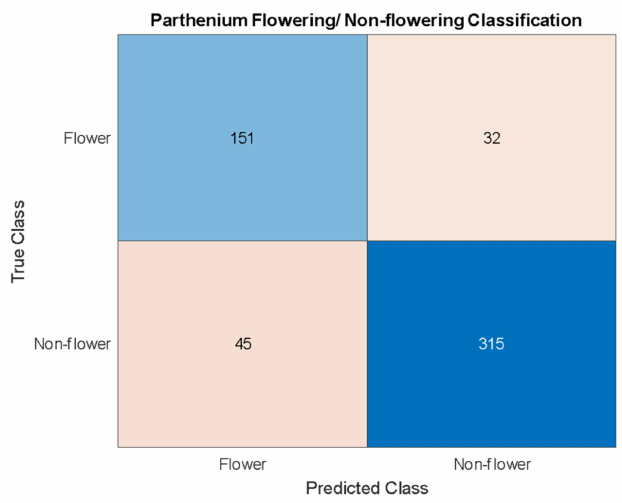
Figure 10. Confusion matrix depicting predicted parthenium weed/background class numbers vs. true parthenium weed/background class numbers. The background includes control plants and no plants. The resulting performance metrics are indicated in Table 3.